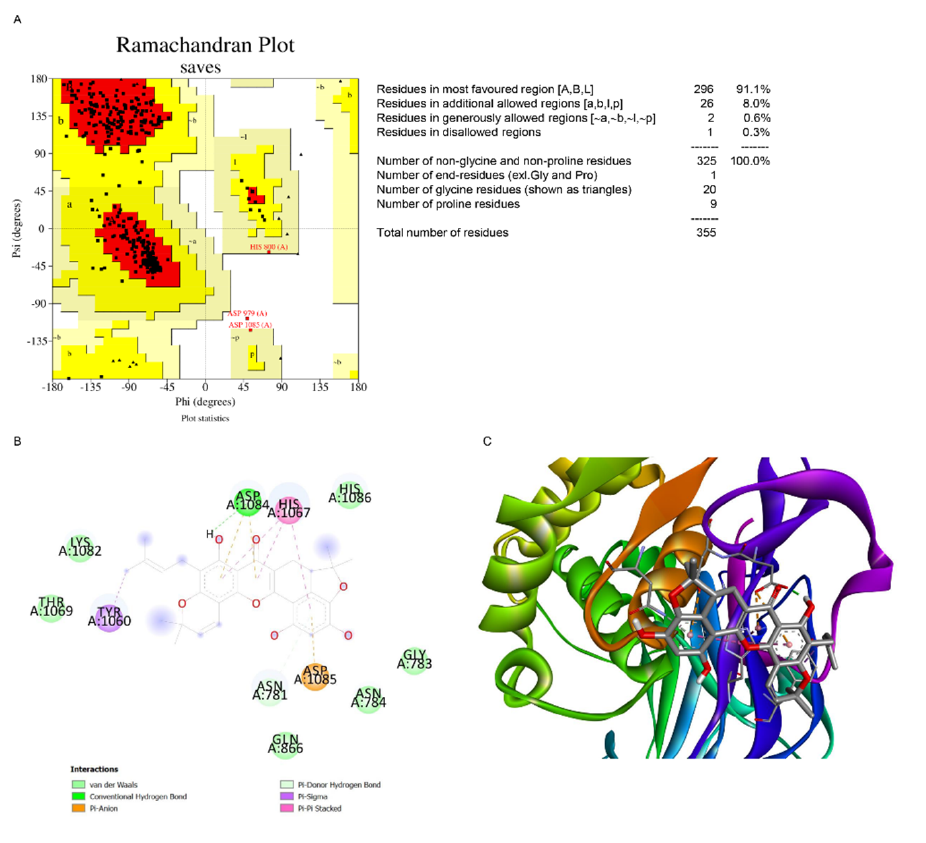
Figure 7. Molecular docking of artonin F at the catalytic site of USP8. ( A ) Ramachandran plot of